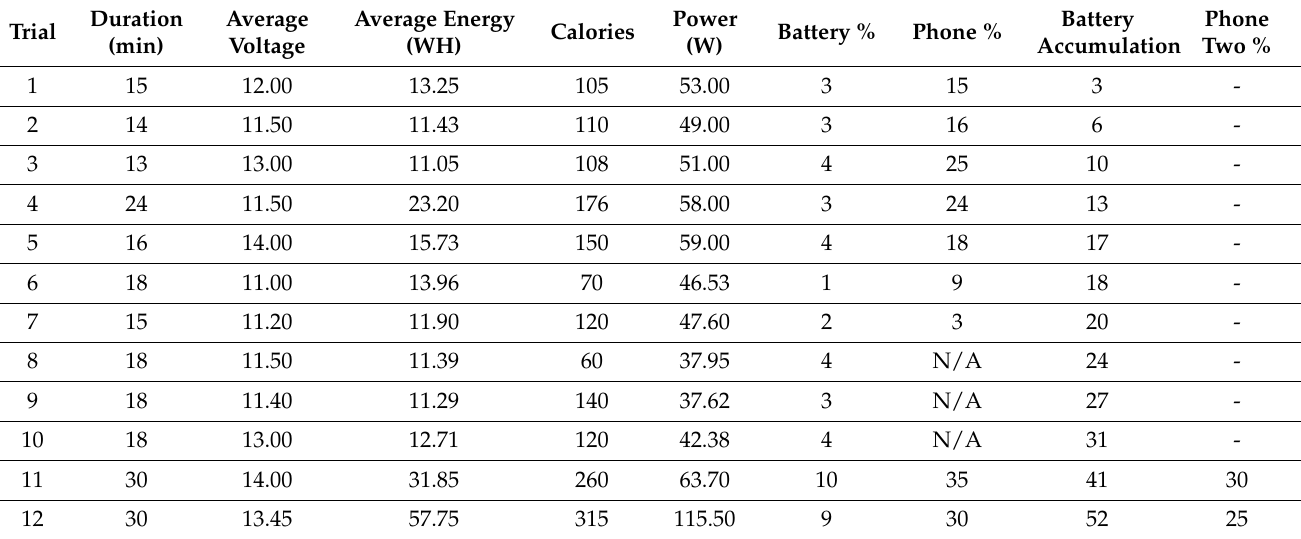
Table 3. Raw data collected from the